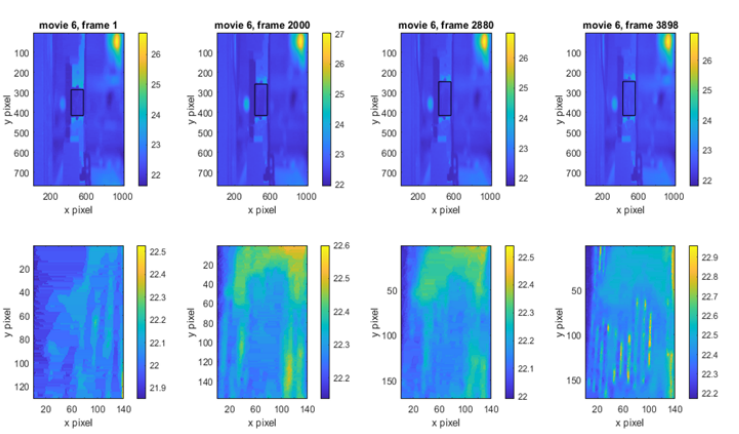
Figure A2. Preliminary analysis using thermal